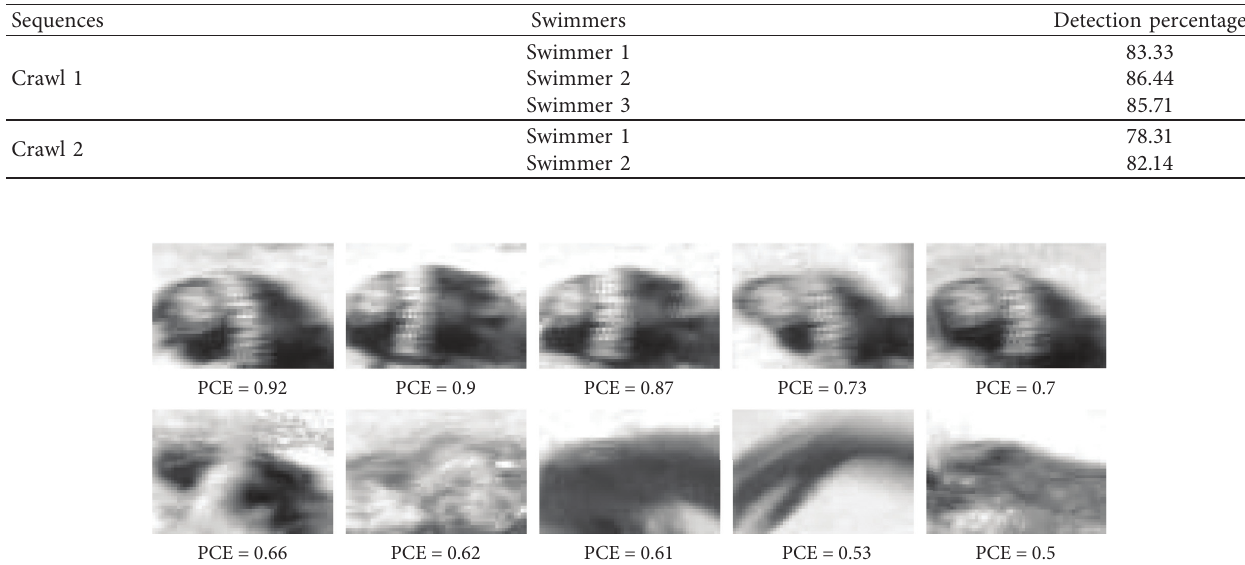
Figure 16: Validation of the initial references according to a PCE-based decision criterion. Detected targets are classified by decreasing order of PCE values. The three validated targets are those with the highest PCE. Swimming Championships in Limoges, France, April